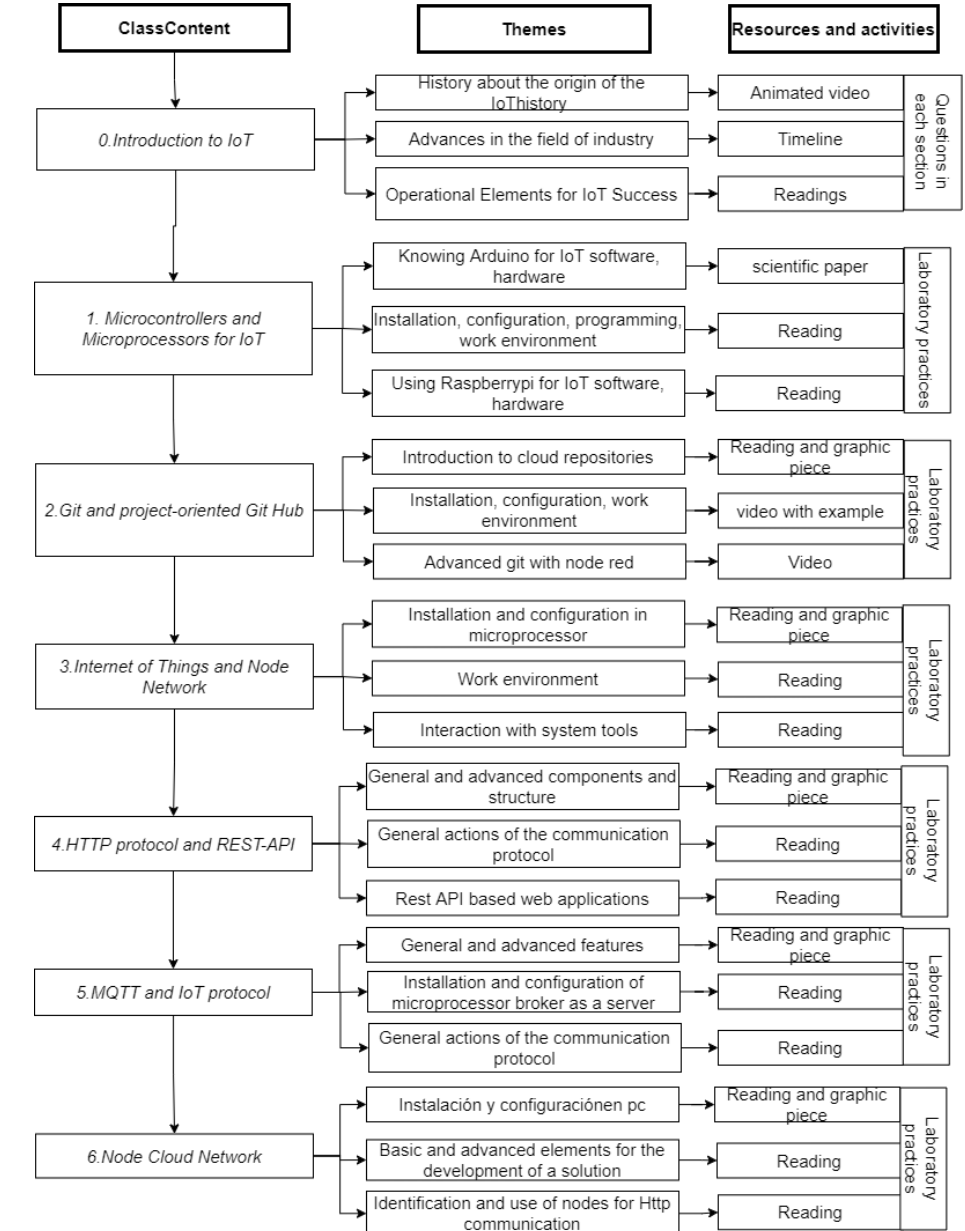
Figure 6. The content structure of the subject from Modules Zero to Six.